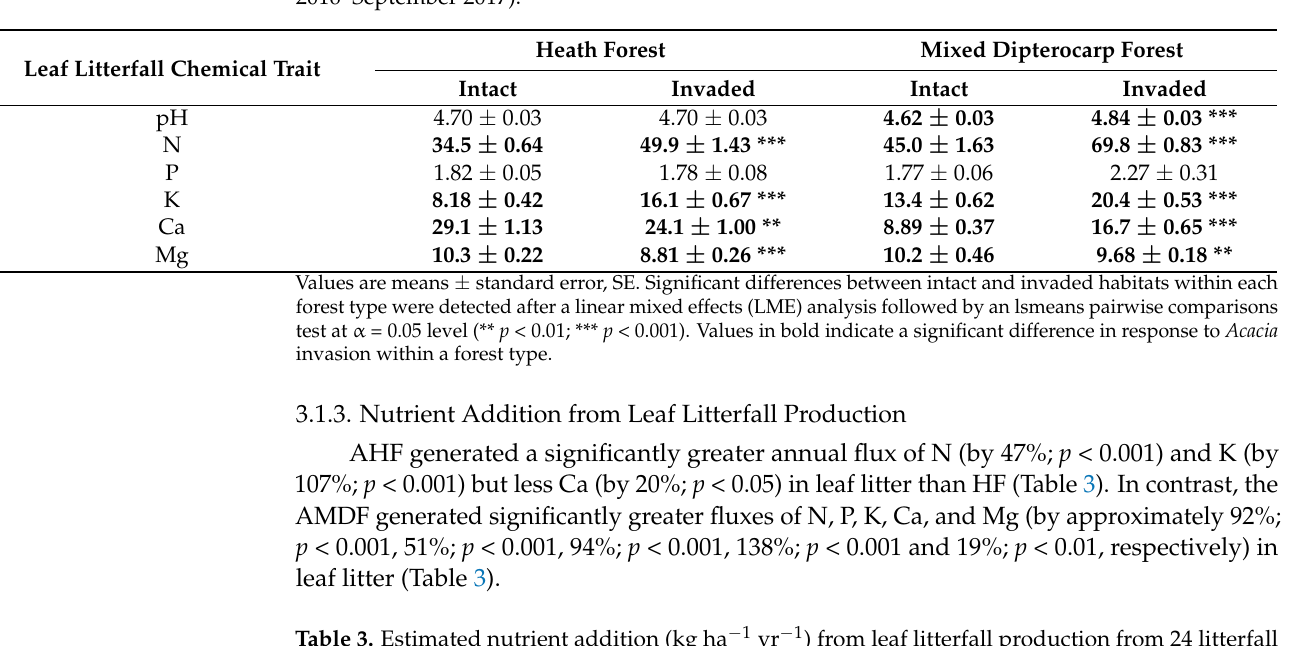
Table 2. Mean pH and nutrient concentrations from leaf litterfall production (N, P, K, Ca, and Mg) expressed in mg g − 1 from 24 litterfall traps in four habitat types (intact and Acacia -invaded heath forest; and intact and Acacia -invaded mixed dipterocarp forest) over a 12-month period (October